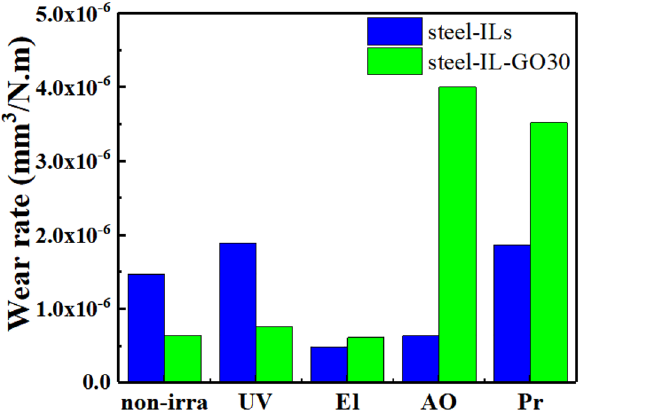
Figure 2. The corresponding disc wear